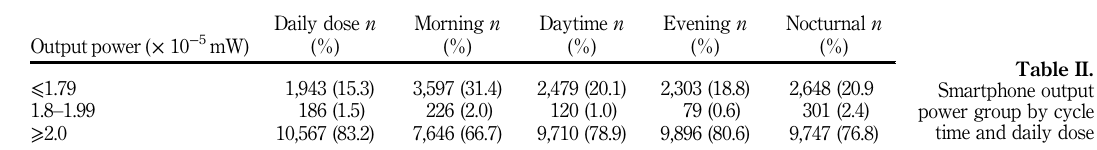
Table II. Smartphone